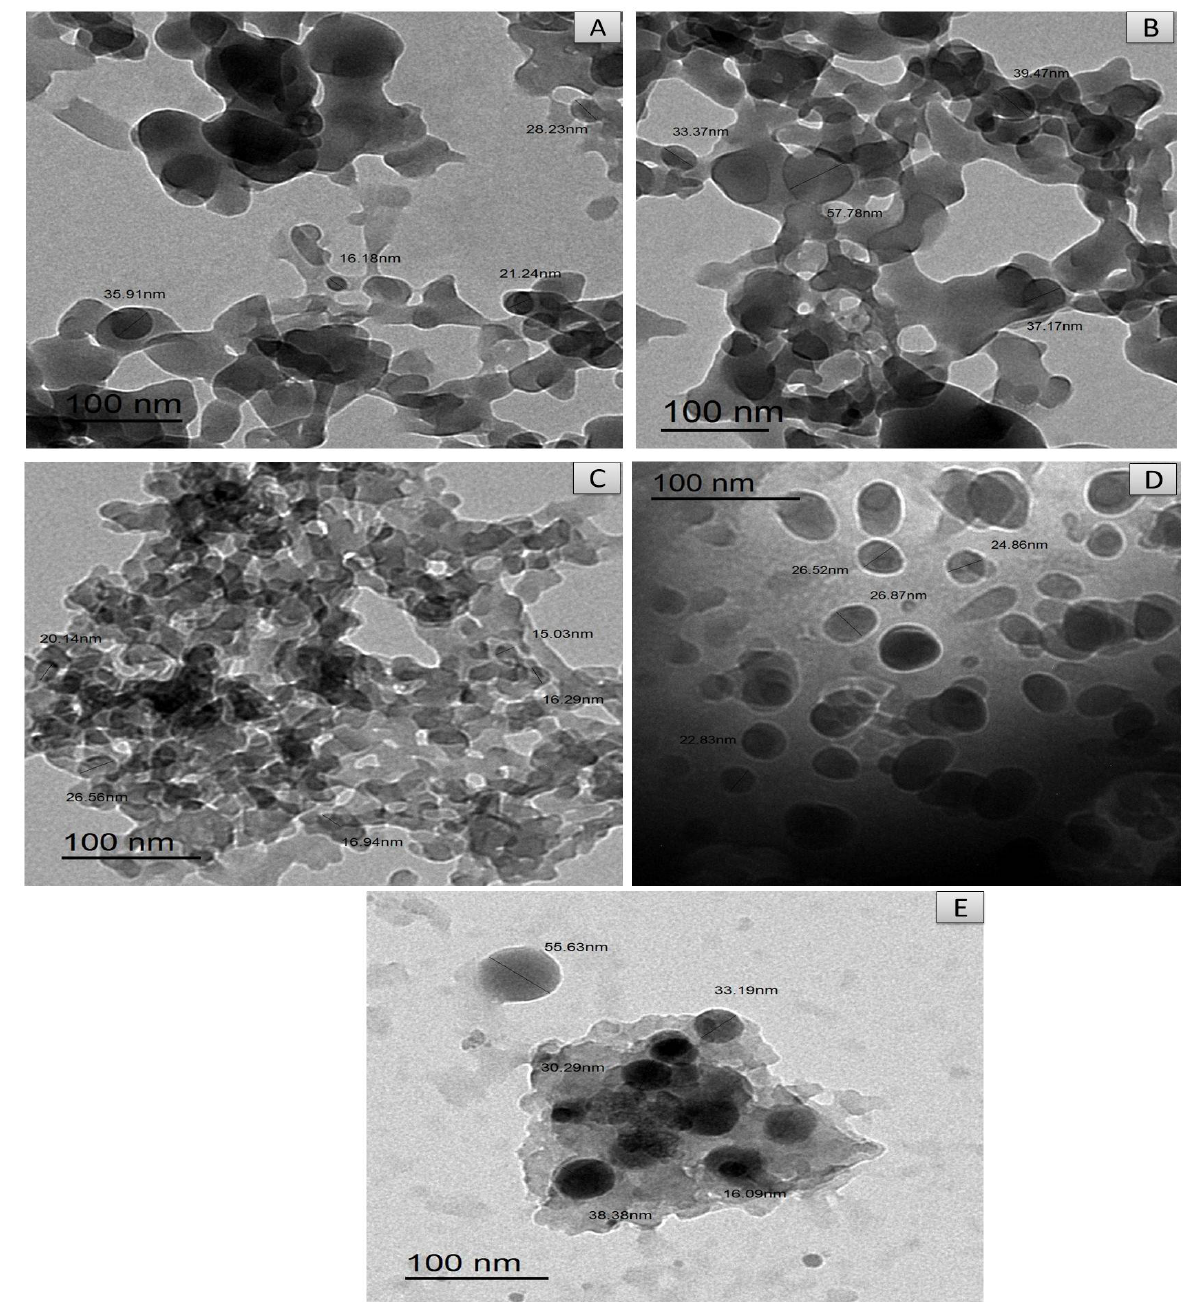
Figure 7. TEM ( A ) Cu, ( B ) Mg, ( C ) Fe, ( D ) Zn and ( E ) Se CFX